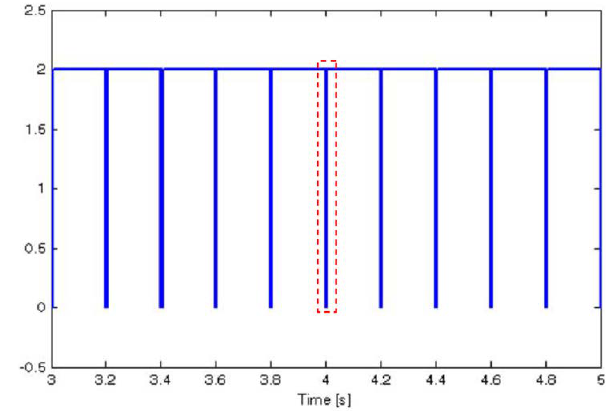
Figure 26. Relation of sgn( ˙ x) and sgn(z)